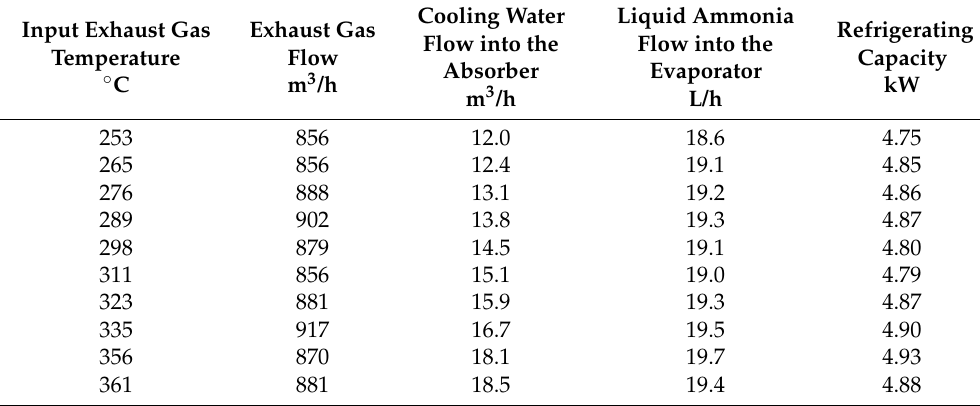
Table 2. The selected 10 sets of measured